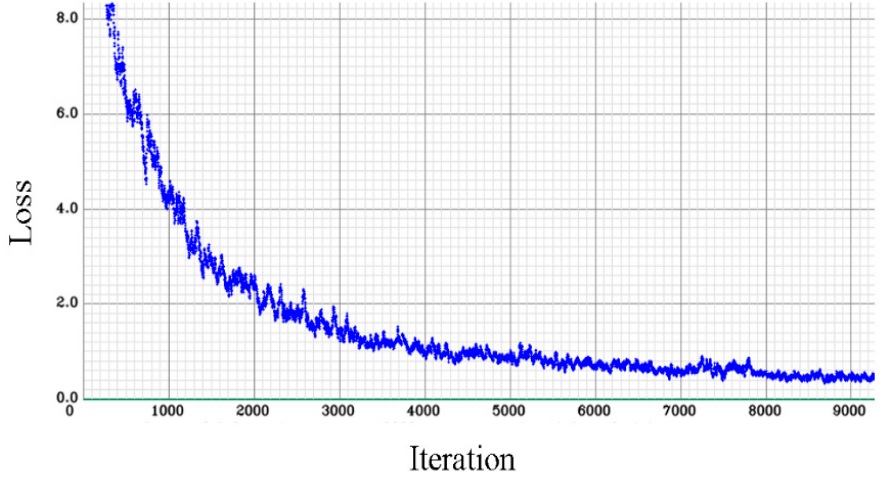
Figure 6. Trend plots of the loss function for